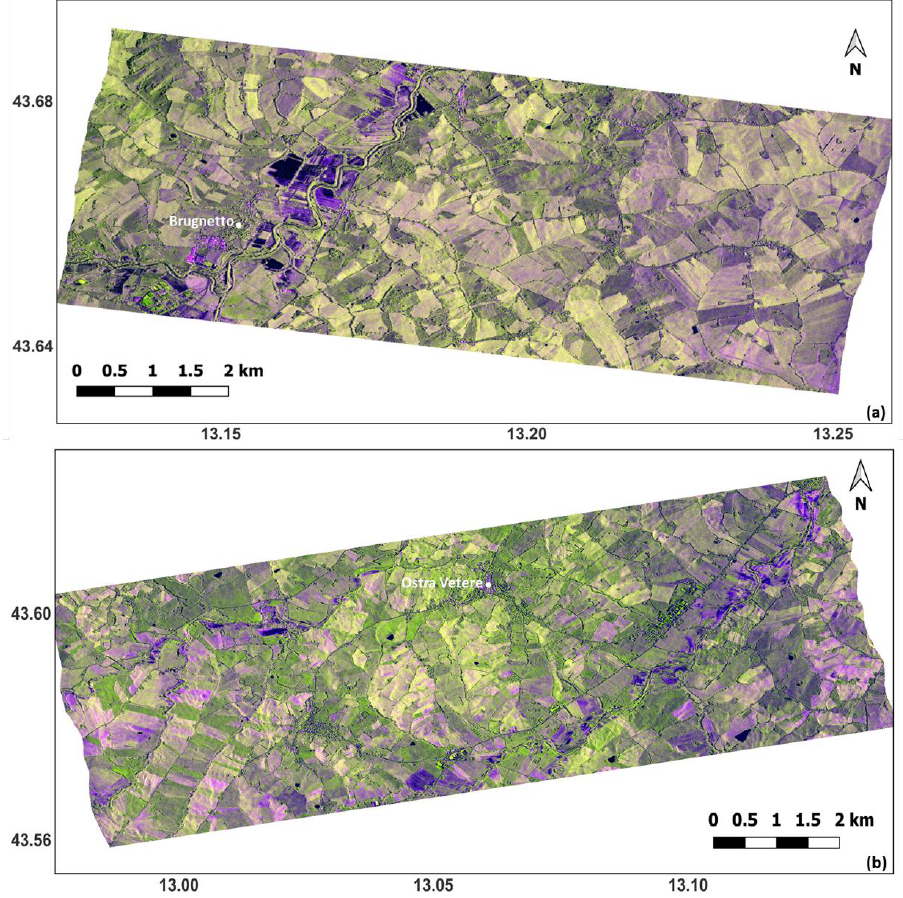
Figure 2. RGB color composites produced using the CSG images of the 2022 Marche flood (red: σ 0HH , green: σ 0HV , blue: σ 0HH − σ 0HV ). The backscattering coefficients are in dB units. Upper panel ( a ): image acquired on 17 September 2022 (Brugnetto area); lower panel ( b ): image acquired on 18 September 2022 (Ostra Vetere area). COSMO-SkyMed Product-© ASI-Agenzia Spaziale Italiana-2022. All rights reserved.